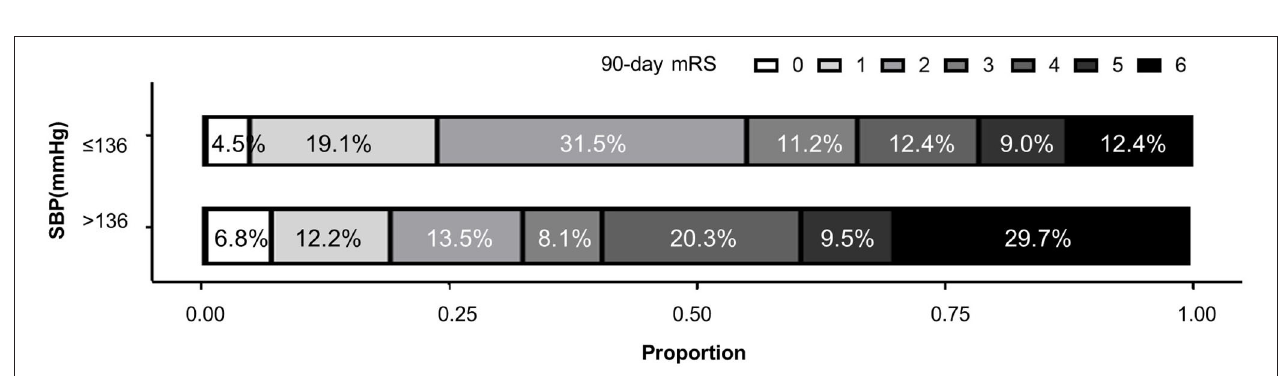
FIGURE 2 | Association of 90-day mRS and the first postoperative SBP. mRS, modified Rankin Scale. (A) A generalized additive model with the line shows predictive values of 90-day mRS score according to the first postoperative SBP (the shade represents 95% CI of them). (B) Linear regression model for the first postoperative SBP and the incidence of poor outcome (mRS 3–6).